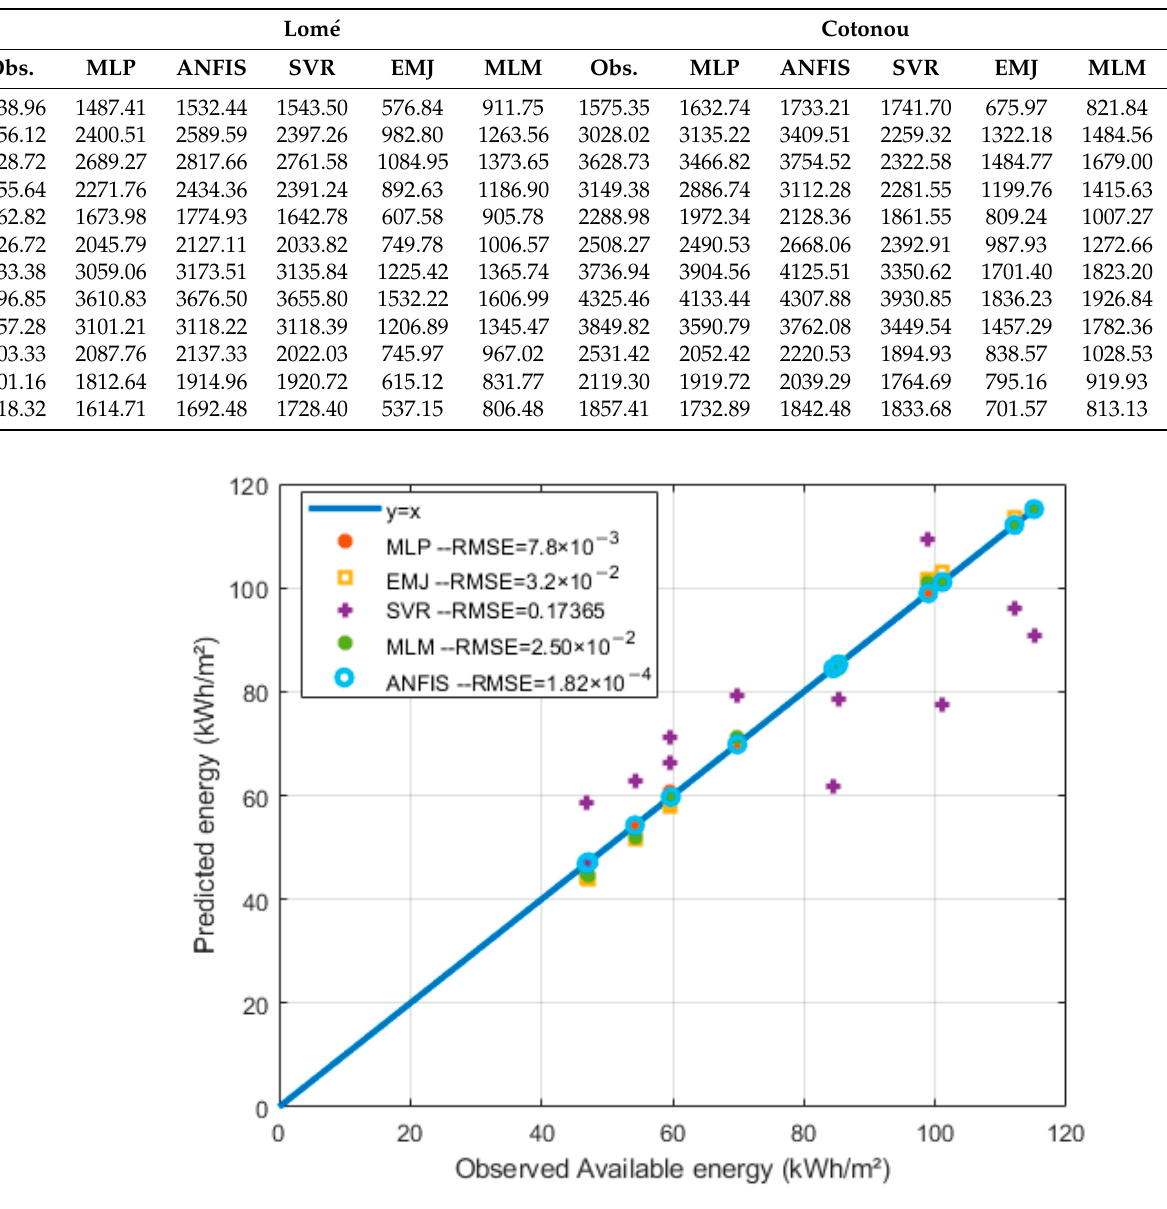
Figure 14. Cotonou: correlation between observed and estimated available energy density.